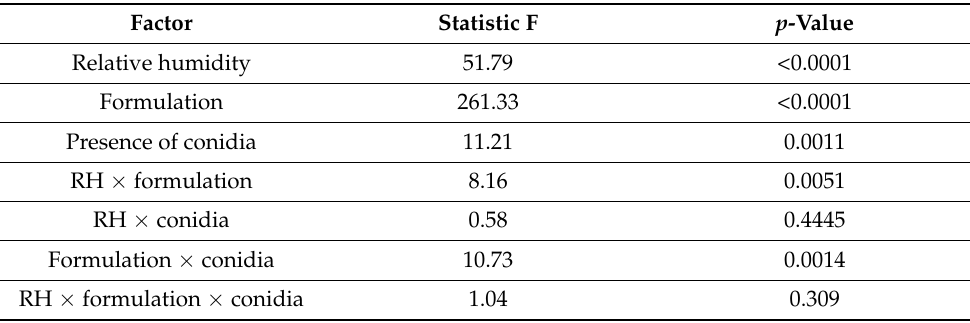
Table 7. Statistical significance of various factors on disease progression, as examined by a non-parametric Wilcoxon text, by day post-inoculation.